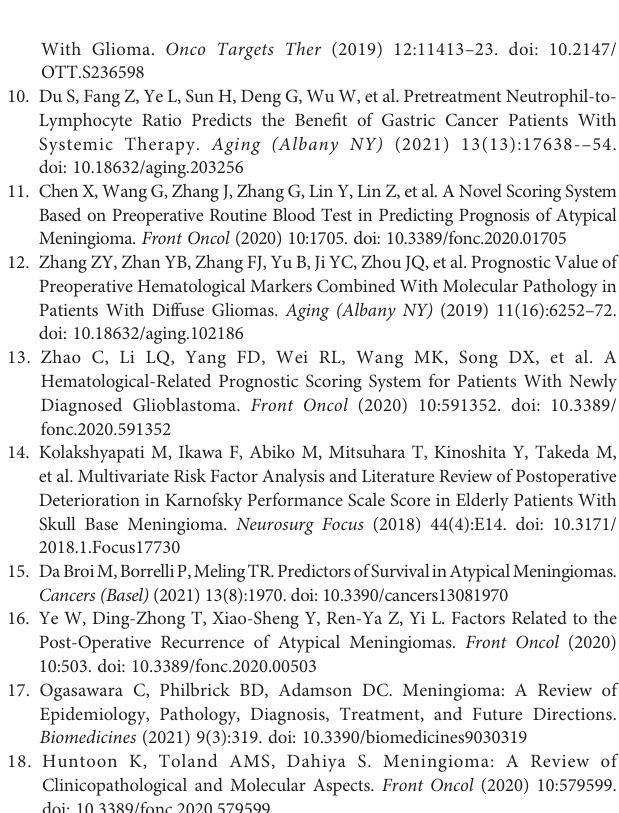
Supplementary Table 1 | Univariate COX regression analysis for hematological parameters. Supplementary Figure 1 | Time-dependent ROC cures of hematological parameters. Supplementary Figure 2 | Time-dependent ROC curves for predictive factors in the training cohort and test cohort. Supplementary Figure 3 | Kaplan-Meier analysis curve for patients with atypical meningiomas categorized by extent of resection and postoperative